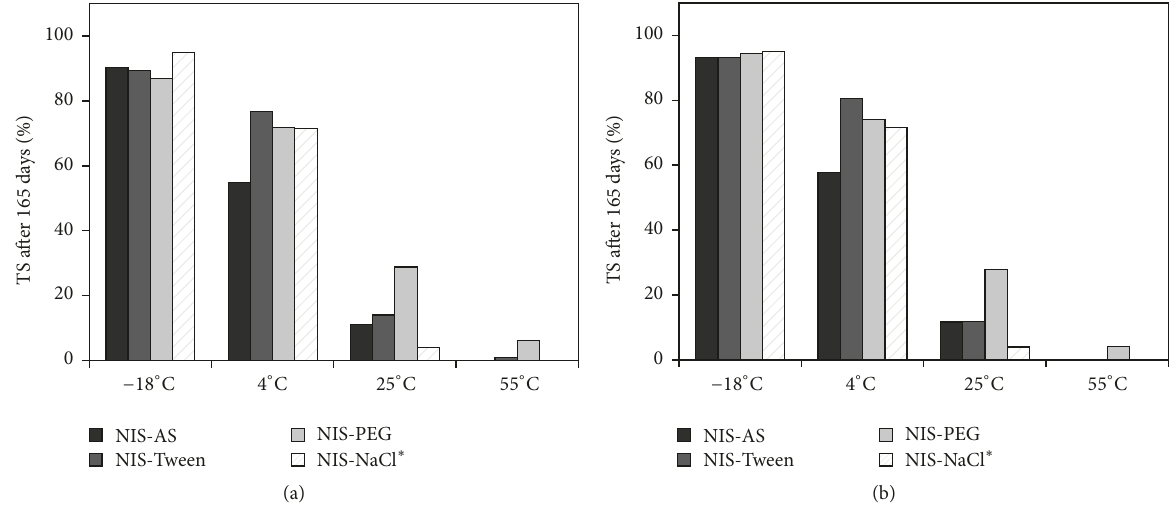
Figure 3: Thermal stability (TS) after 165 days of storage at various temperatures determined by electrophoresis-Bradford method (a) and by HPLC (b). Data points are average values of three independent analyses. Standard errors were less than 10%. ∗ Commercial